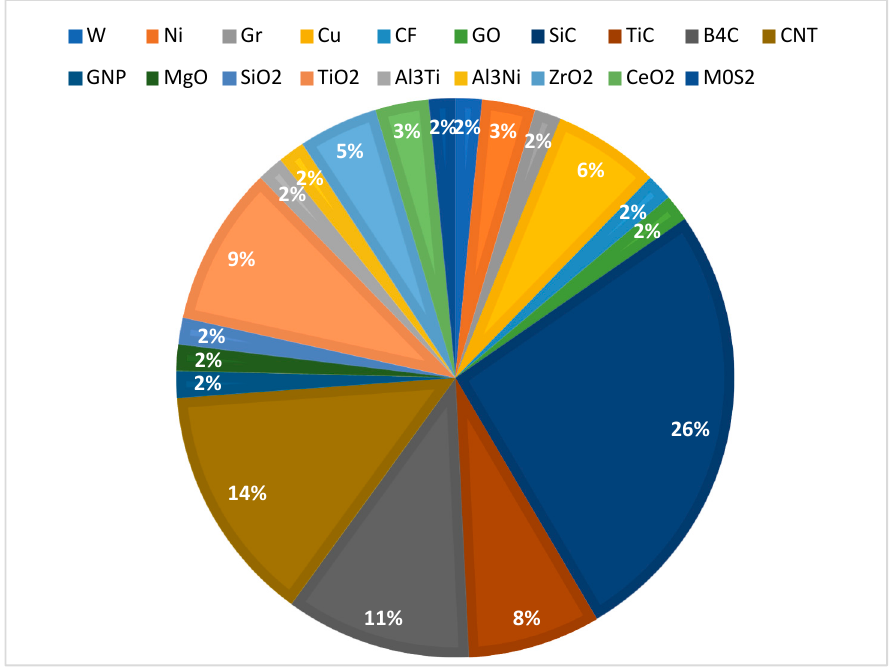
Figure 2. Graphical representation of reinforcement usage on different base materials.